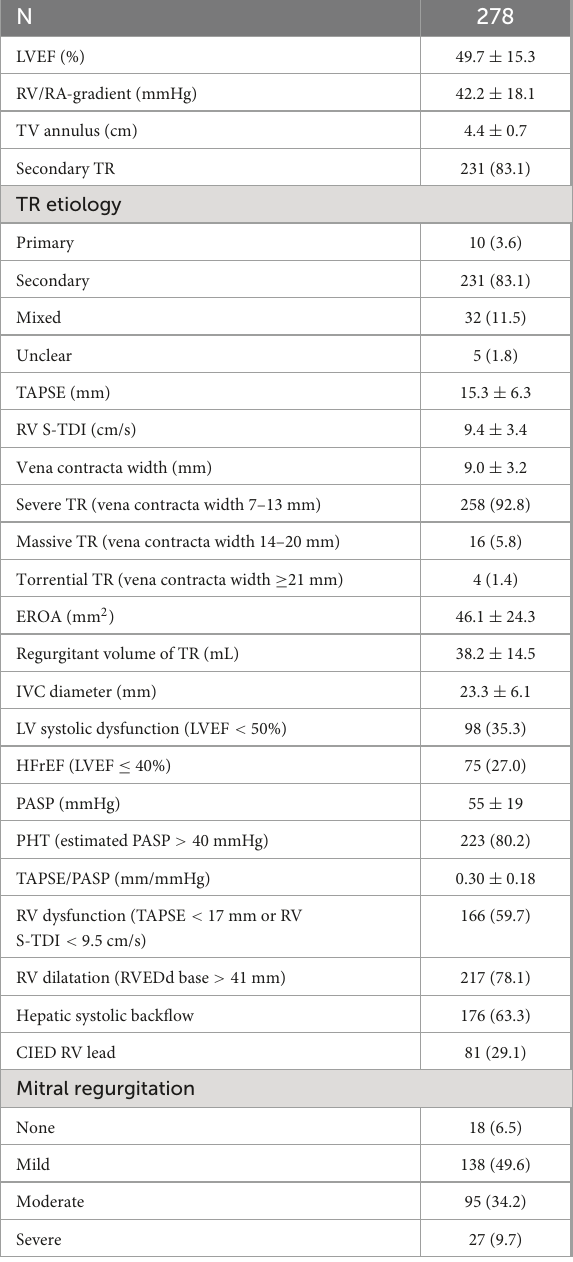
TABLE 2 Baseline echocardiographic